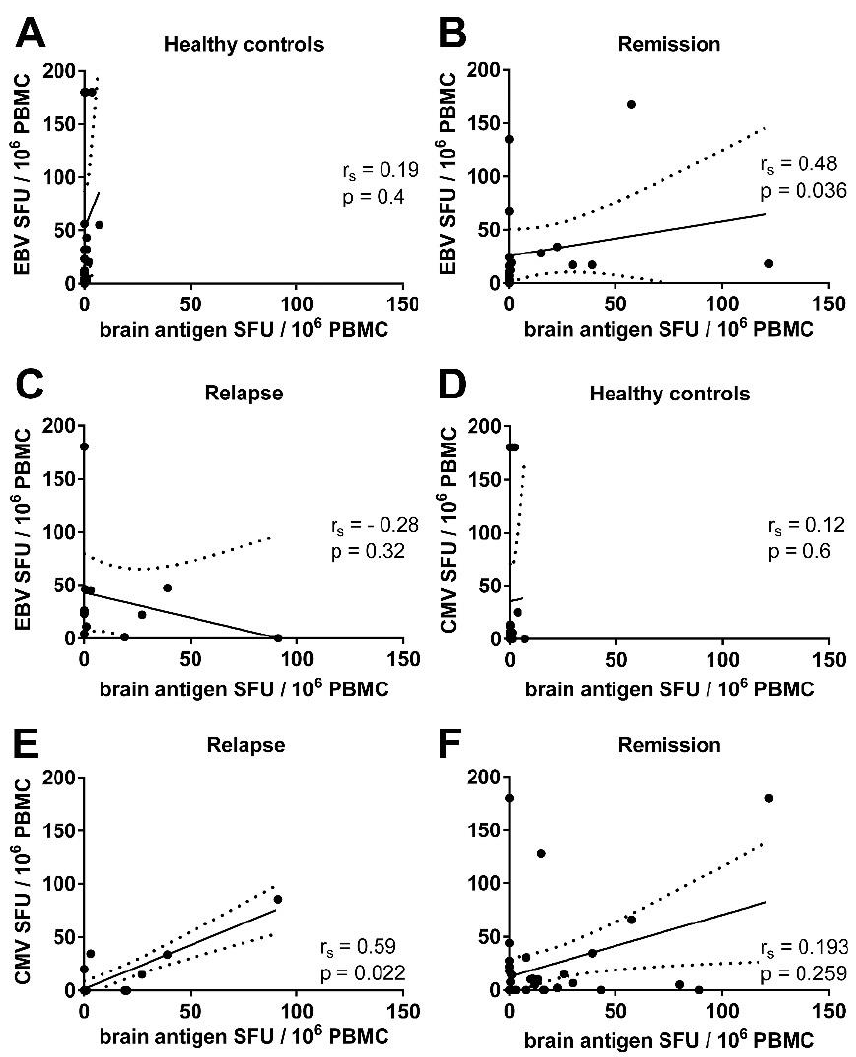
Figure 4. Correlation between the frequencies of virus- and brain antigen-specific B cells in the blood of MS patients. Spearman’s rank correlation (r s ) representing the ratio between EBV and brain antigen-specific B cell numbers in the polyclonally stimulated PBMC population of healthy controls ( A ); MS patients in remission ( B ) and MS patients experiencing an acute relapse ( C ); ( D – F ) Correlation between CMV and brain antigen-specific B cell numbers in healthy controls ( D ); MS patients in remission ( E ) and MS patients experiencing an acute relapse ( F ). Lines represent the linear regression, and dotted lines the 95% confidence interval.